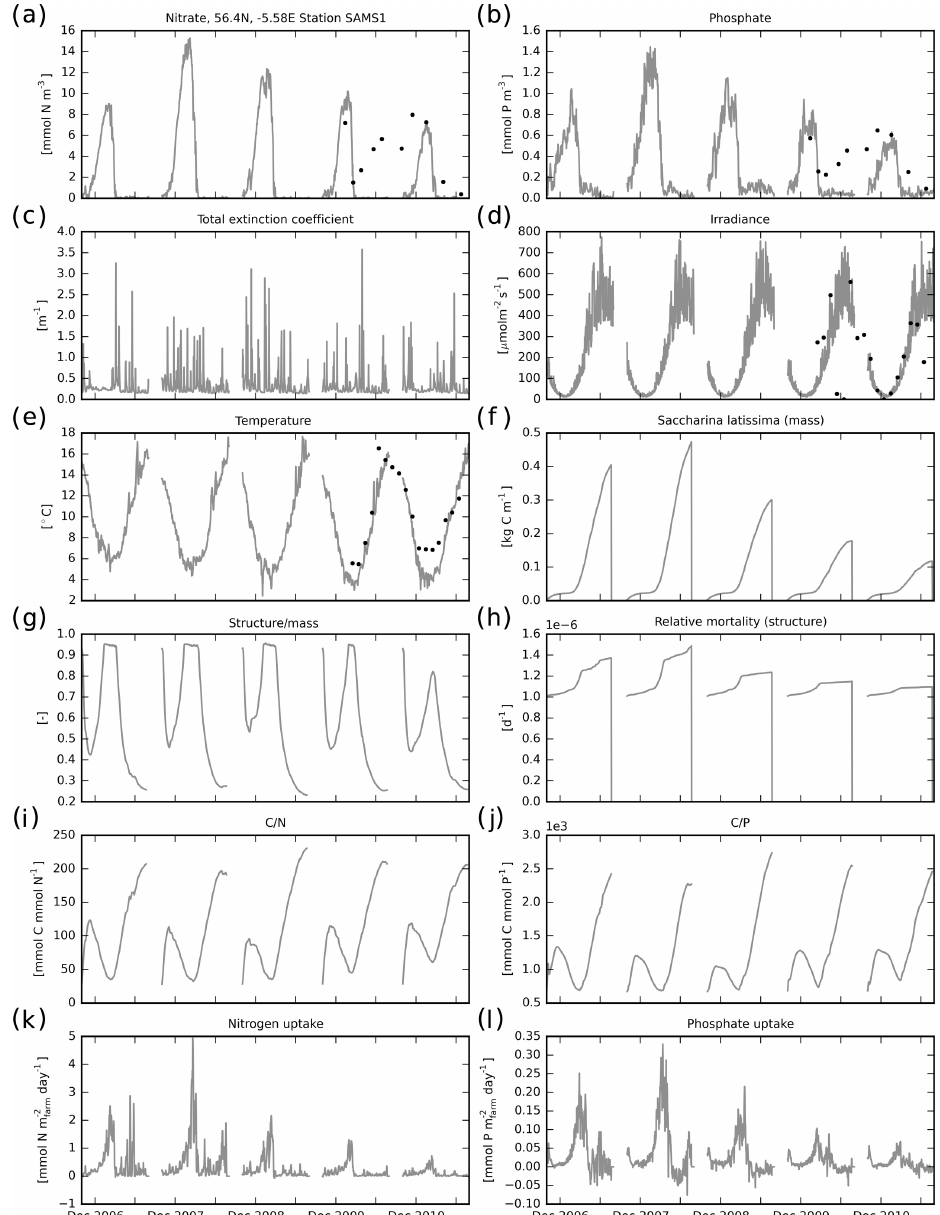
Figure 10. Model results for the Sound of Kerrera farm site. (a) Surface nitrate concentration; (b) surface phosphate concentration; (c) total extinction coefficient at the surface (excluding contribution by macroalgae); (d) irradiance at the surface; (e) surface water temperature; (f) macroalgae carbon biomass per metre of line; (g) mass of macroalgae structure over total macroalgae mass ratio; (h) relative mortality of macroalgae structure; (i) C / N ratio of macroalgae; (j) C / P ratio of macroalgae; (k) farm net nitrogen uptake; (l) farm net phosphate uptake. Black dots are observations: in panels (a, b) from nutrient samples; in panels (d, e) monthly averages from a data